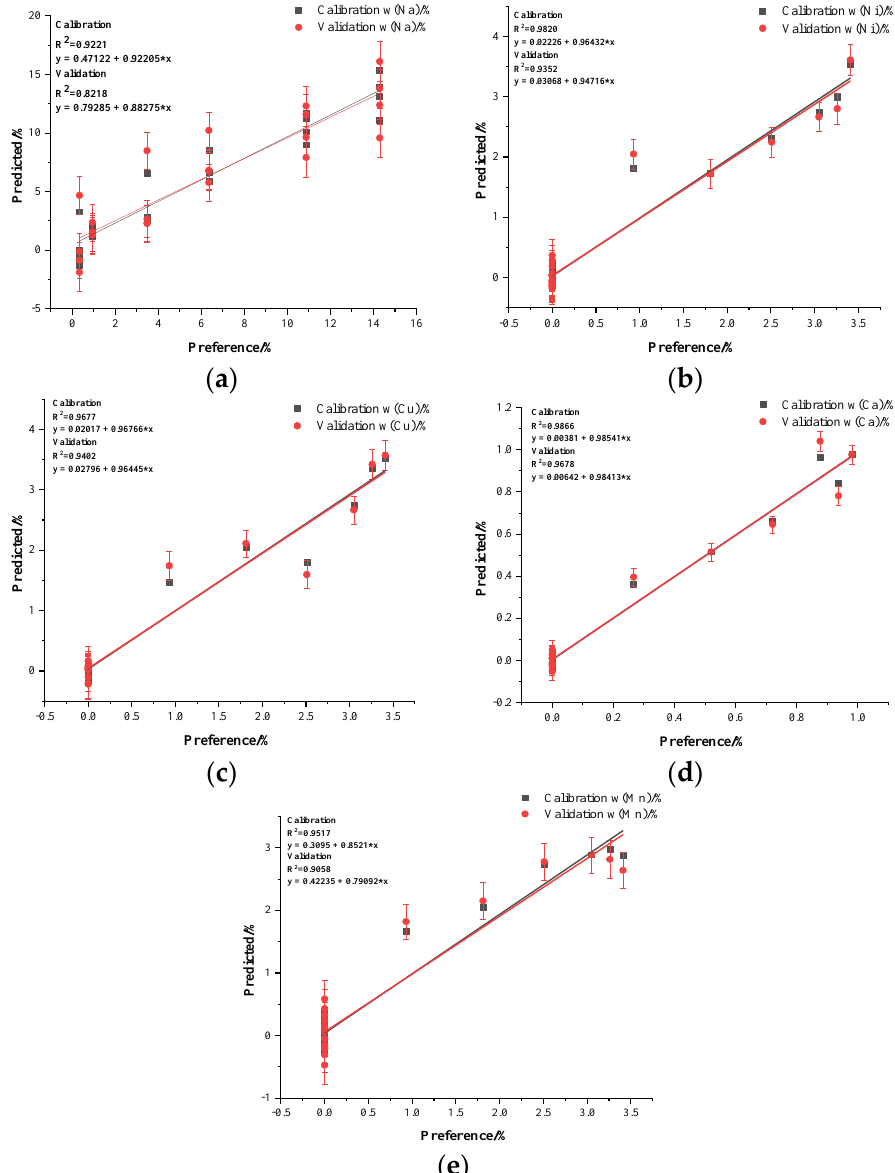
Figure 9. Model and cross-validation plots produced with the PLSR, where ( a – e ) correspond to Na, Ni, Cu, Ca and Mn.